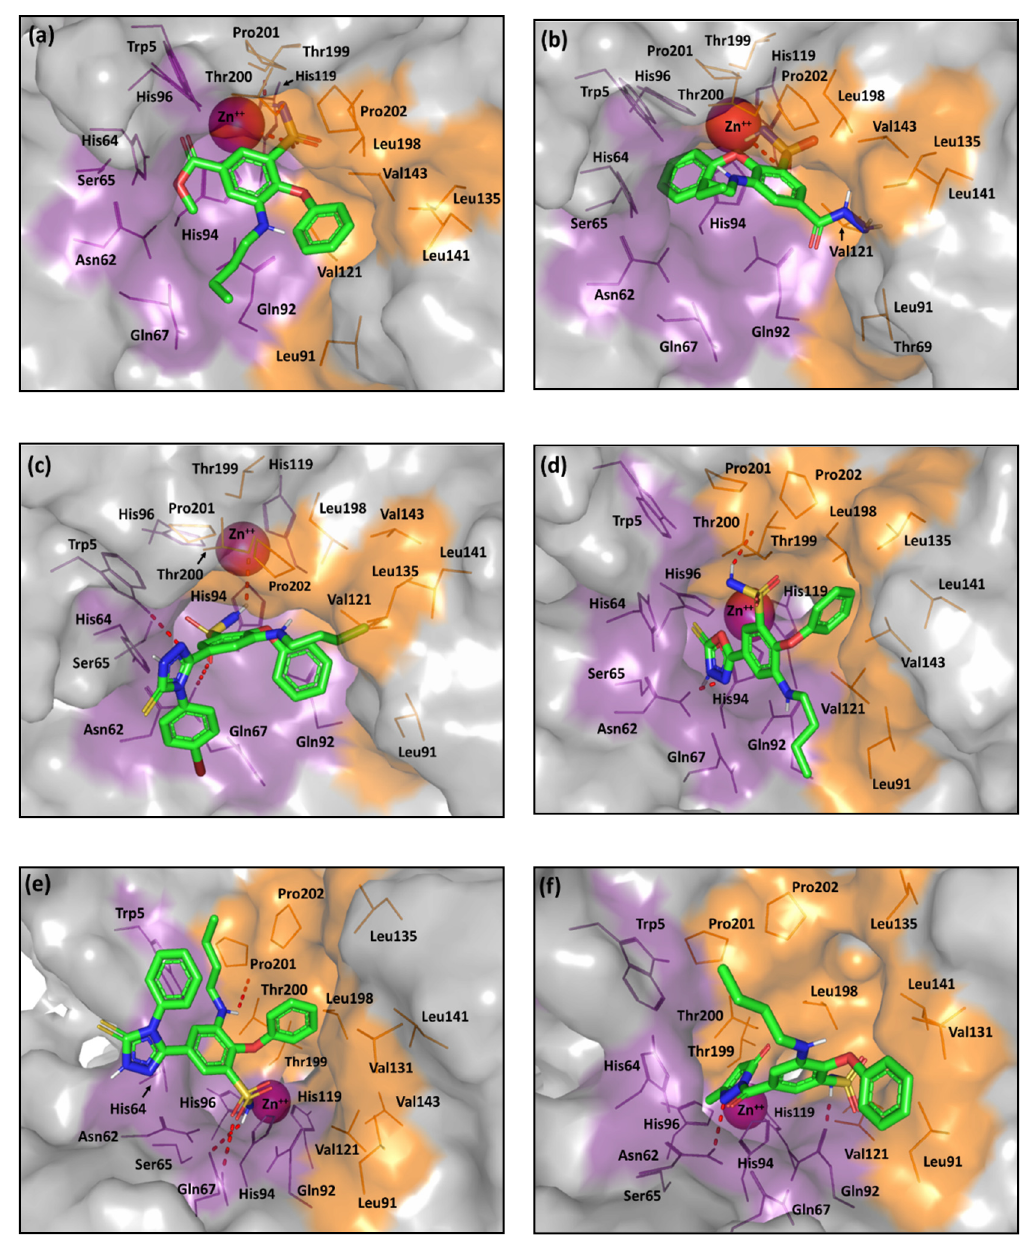
Figure 7. The predicted binding modes of the investigated compounds (sticks) at the h CA-IX binding site (PDB ID: 3iai); ( a ) 2 ; ( b ) 3 ; ( c ) 9c ; ( d ) 5 ; ( e ) 9a ; ( f ) 4 . The active site cleft within the suggested ligand-protein complexes is illustrated as gray surface representation depicting the prosthetic Zn(II) (magenta sphere), as well as the hydrophilic (purple) and hydrophobic (orange) residues as lines. Hydrogen bonding is depicted as red dashed-lines, while polar coordination to Zn(II) as black dashed-lines. Only residues located within 5Å radius of bound ligands are displayed (lines) and labeled with sequence number.